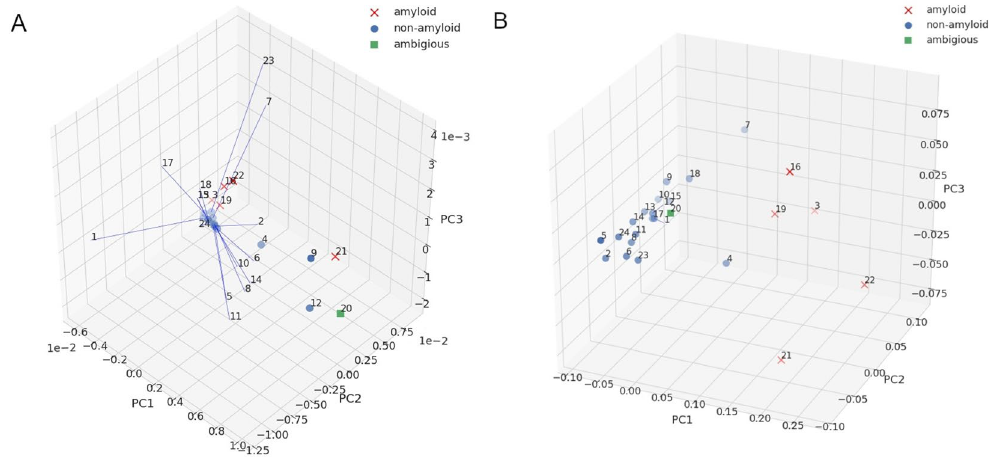
Figure 6. PCA plots for IR spectra of the test set : ( A ) ATR-FTIR. ( B ) IR microscopy. Crosses denote amyloids and dots represent non-amyloids, as identified on the spectra by a human